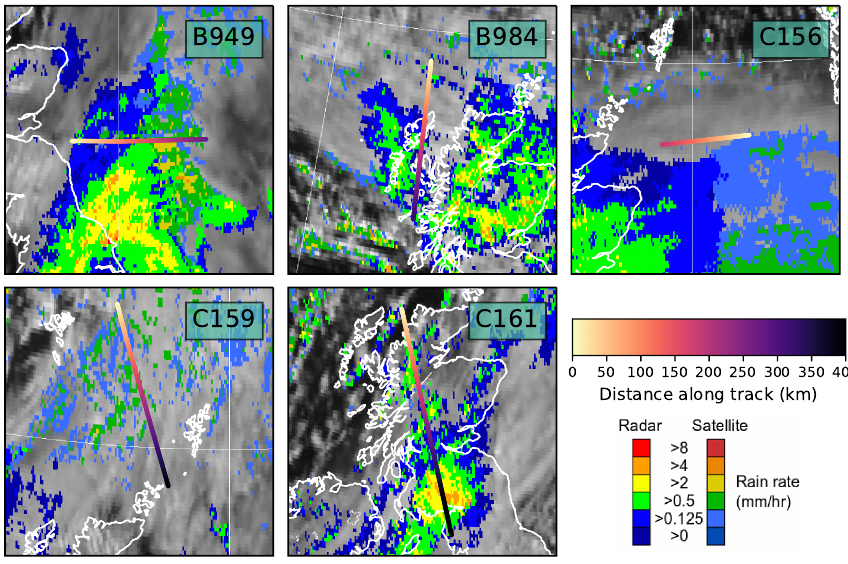
Figure 4. Aircraft positions during high-level runs, overlaid on images from the SEVIRI 0.8 µ m visible channel on Meteosat Second Generation (grey shades) and a combined radar/satellite estimate of rain rate (colours). Data: EUMETSAT.